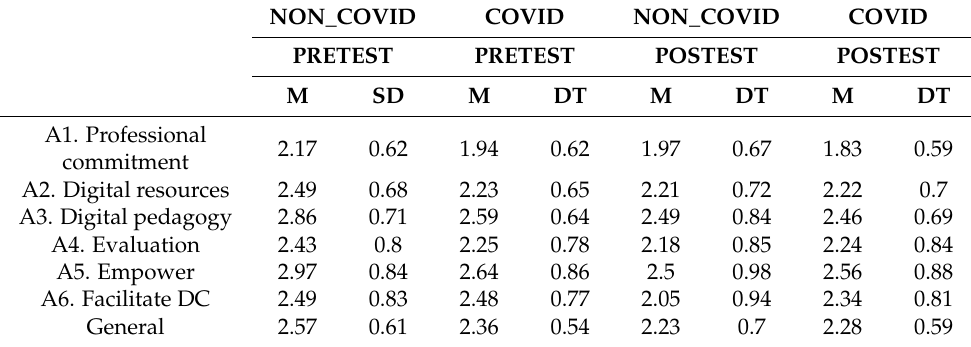
Table 3. Mean and standard deviation by groups and dimensions.